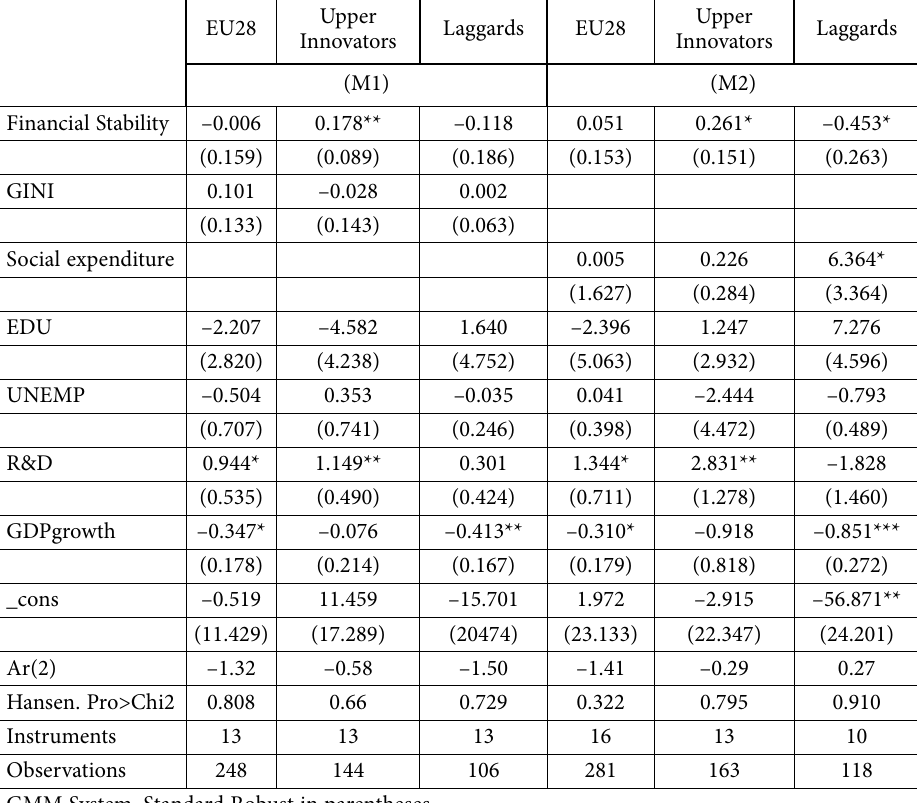
Table 4. Estimation results: patents as dependent variable Upper EU28